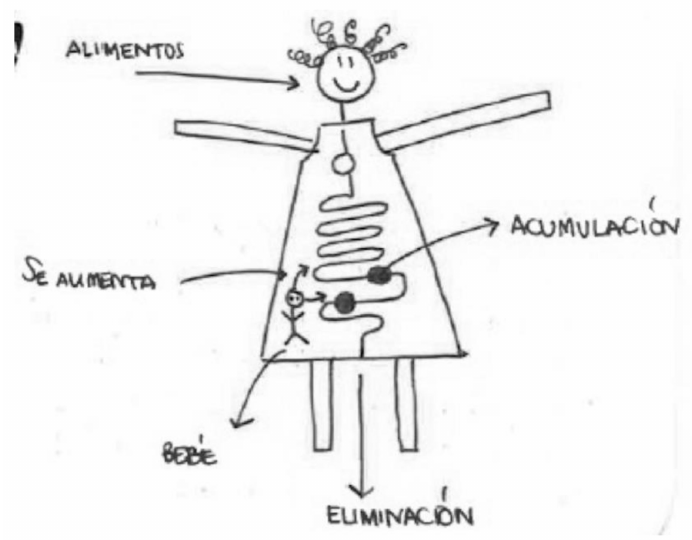
Figure 16. Breastfeeding, secondary education, sealing